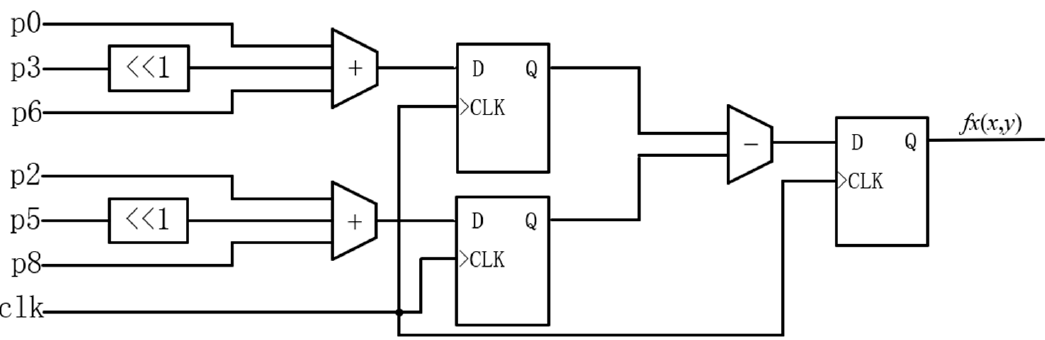
Figure 4. Architecture of Line Buffer.